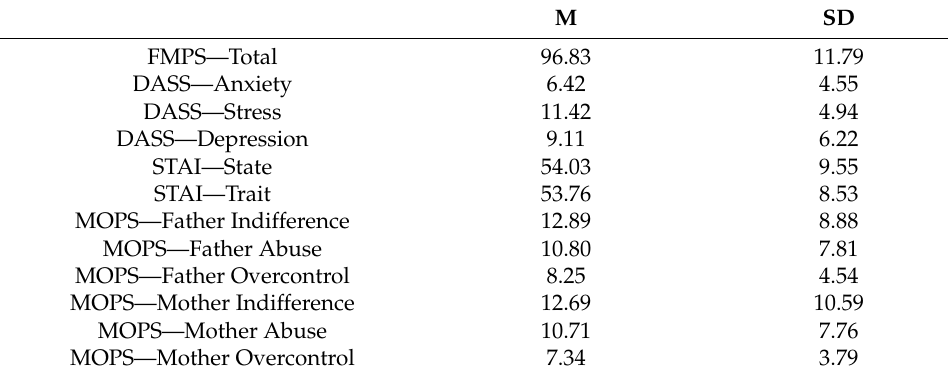
Table 1. Means and standard deviation of all measures in Time 1; n = 81.